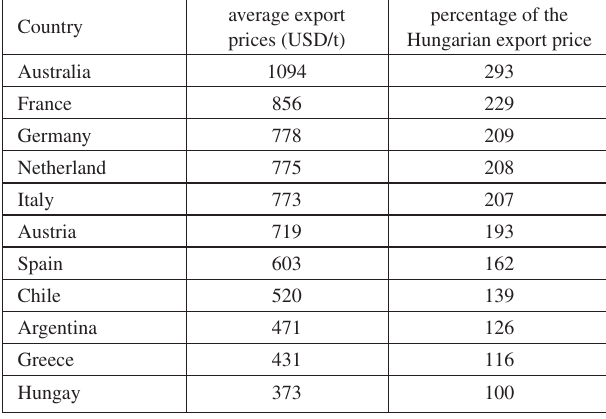
Table 1. Fresh apple export prices of some important apple producing countries (2002–2007 f.o.b. average export